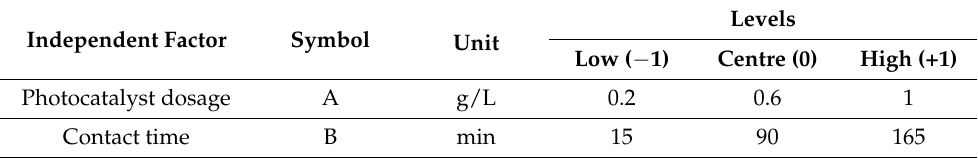
Table 1. Independent variables and quantities utilised for photocatalytic removal of dyes using nanocomposites.